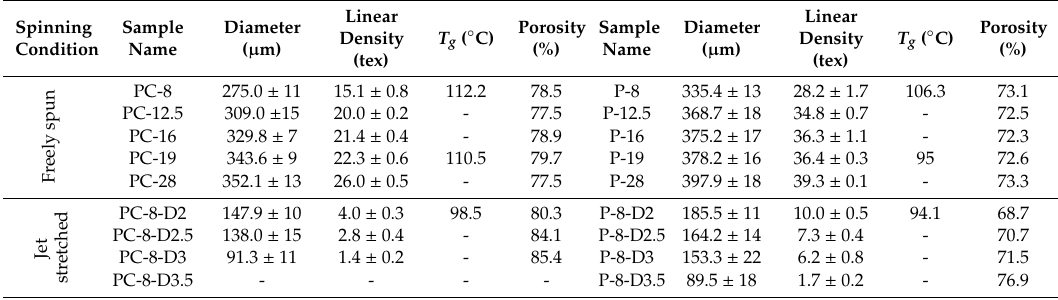
Table 2. Physical properties of PAN and PAN / CNT fibers at di ff erent spinning